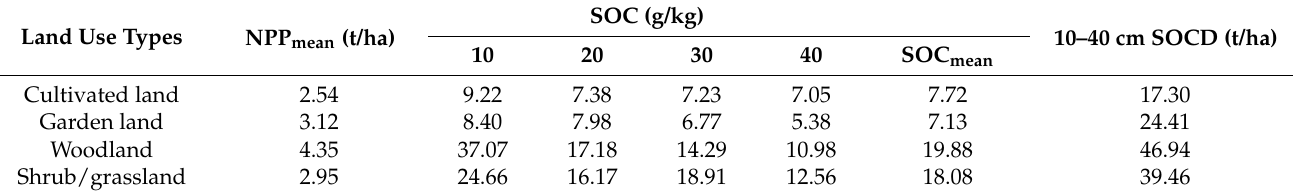
Table 3. Vegetation and soil carbon density of different land uses in Huailai